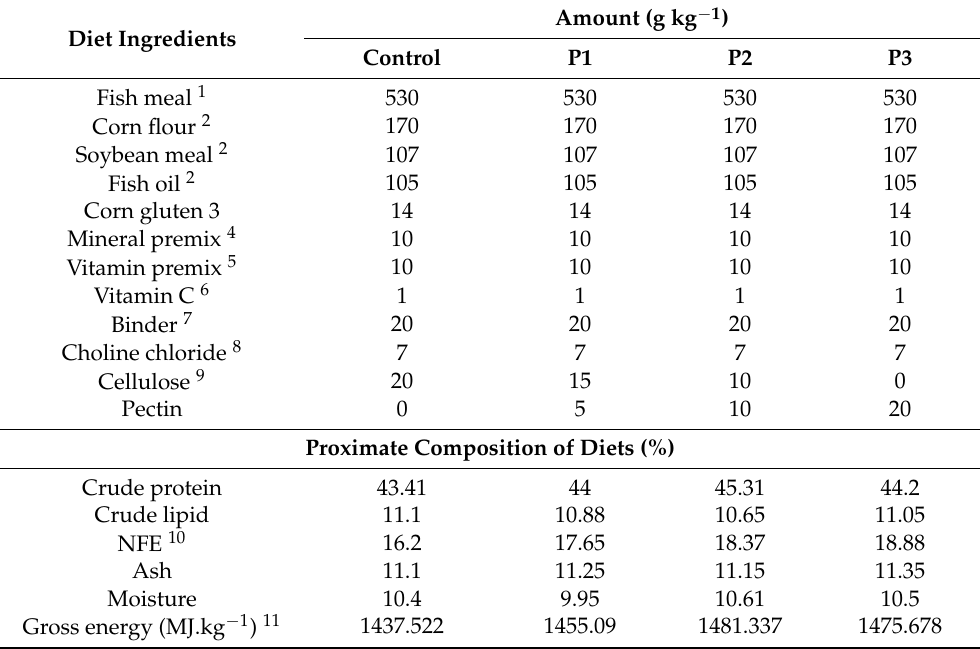
Table 1. Formulation and proximate composition of experimental diets incorporated with control: 0, P1: 5, P2: 10, and P3: 20 g of apple pomace derived pectin